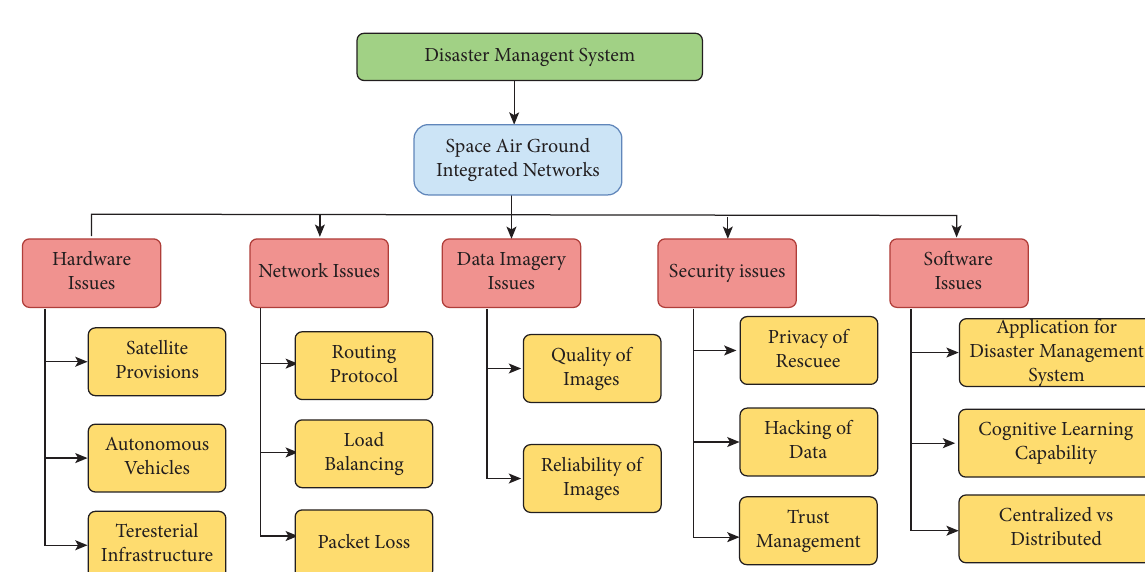
Figure 6: Different challenges and